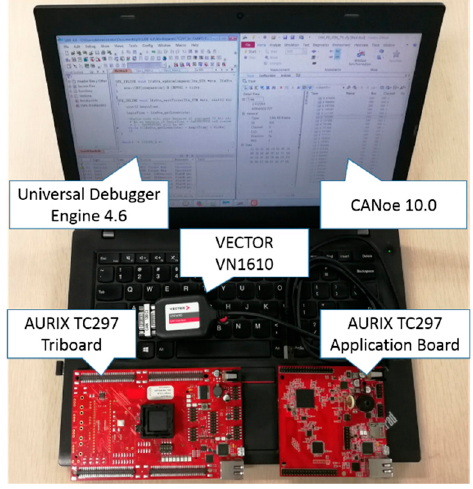
Figure 11. Experiment devices.